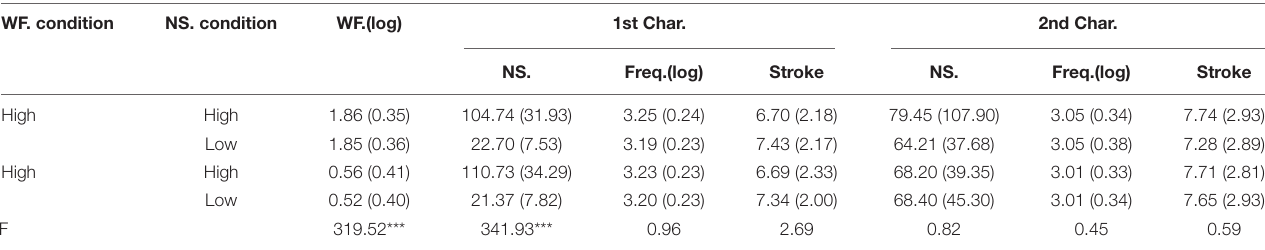
TABLE 1 | Mean and standard deviation (standard deviation in brackets) of four types of true words on various indicators. WF.